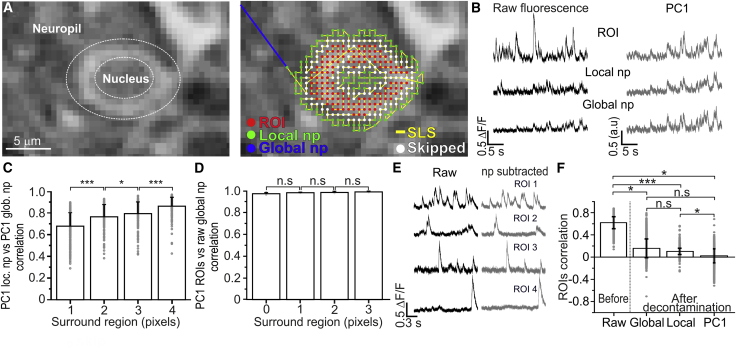
Neuropil Decontamination in SLS(A) Left: a GCaMP6s-expressing layer IV cell. Right: the pixels belonging to the ROI (red), the local neuropil (green, local np), and the global neuropil (blue, global np) are shown. SLS trajectory is shown in yellow and pixels at the border between the ROI and the local np were not considered (white, skipped).(B) Black traces on the left: raw fluorescence signal over time from SLS on one representative cell (ROI), its corresponding local np, and the global np. Grey traces on the right: PC1 computed from the combined pixels of all the ROIs (upper trace), PC1 of all local np regions (middle trace), and PC1 of the whole global np (bottom trace).(C) Pearson’s correlation between the PC1 of the signal from local np regions and the PC1 of the global np regions as a function surround region dimension (from 0 to 3 pixels). n = 172 ROIs from 11 SLS for each surround region value; paired t test, p = 1E-11 for surround 1 pixel versus surround 2 pixel; p = 0.04 for surround 2 pixel versus surround 3 pixels; p = 2E-9 for surround 3 versus surround 4 pixels.(D) Pearson’s correlation between the PC1 of the ROI signal and the global np as a function of the surround region dimension (from 0 to 3 pixels). n = 90 ROIs from 5 SLS for each surround region value; paired t test, p = 0.1 for surrond 0 pixel versus surround 1 pixel; p = 0.1 for surround 1 pixel versus surround 2 pixels; p = 0.96 for surround 2 versus surround 3 pixels.(E) Left: raw fluorescence over time for four ROIs (black traces) acquired in SLS. Right: corrected fluorescence signals for the same four ROIs shown on the left after neuropil decontamination (gray traces). Neuropil correction is obtained subtracting from the raw fluorescence traces the weighted PC1 of the global np signal.(F) Pearson’s correlation across ROIs before (raw) and after neuropil decontamination using different strategies (global np subtraction, local np subtraction, and subtraction of the weighted PC1 of the global np). n = 3,656 ROI pairs from 11 SLS; Wilcoxon rank-sum test, p = 0.02 for raw versus global np subtraction; p = 2E-4 for raw versus local np subtraction; p = 0.02 for raw versus PC1 of the global np; p = 0.08 for global versus local np subtraction; p = 0.07 for global np versus PC1 of the global np subtraction; p = 0.01 for local np versus PC1 of the global np subtraction.